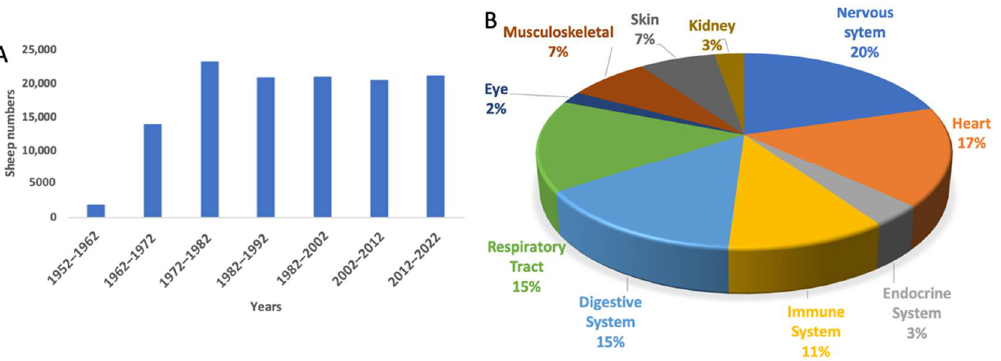
Figure 1. Application of sheep to biomedical research. ( A ) The number of sheep used internationally per decade. ( B ) The pathological conditions for which sheep models have been applied since